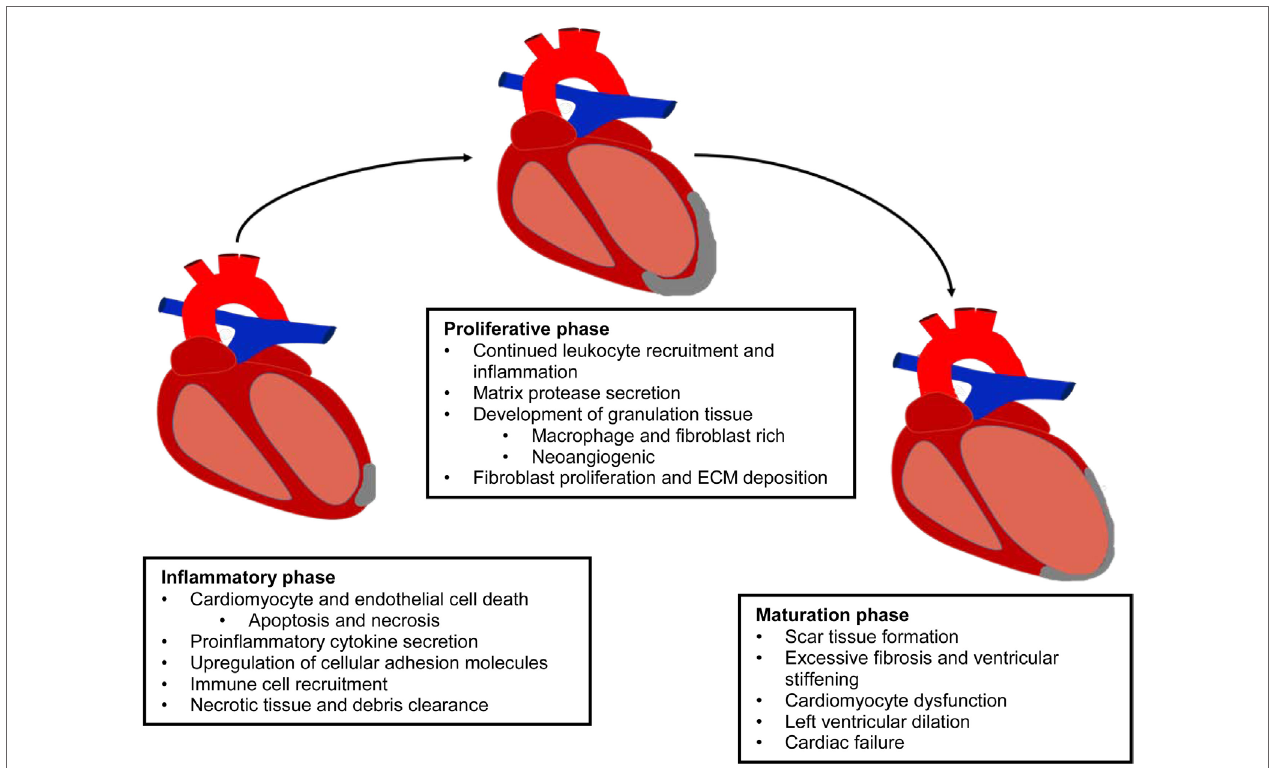
FiGURe 1 | evolution of the infarcted myocardium . MI results in the activation of a multiphase healing process, involving three overlapping phases: the inflammatory, proliferation, and maturation phases. This repair process prevents ventricular rupture, but it is insufficient to protect the myocardium from massive tissue loss and adverse